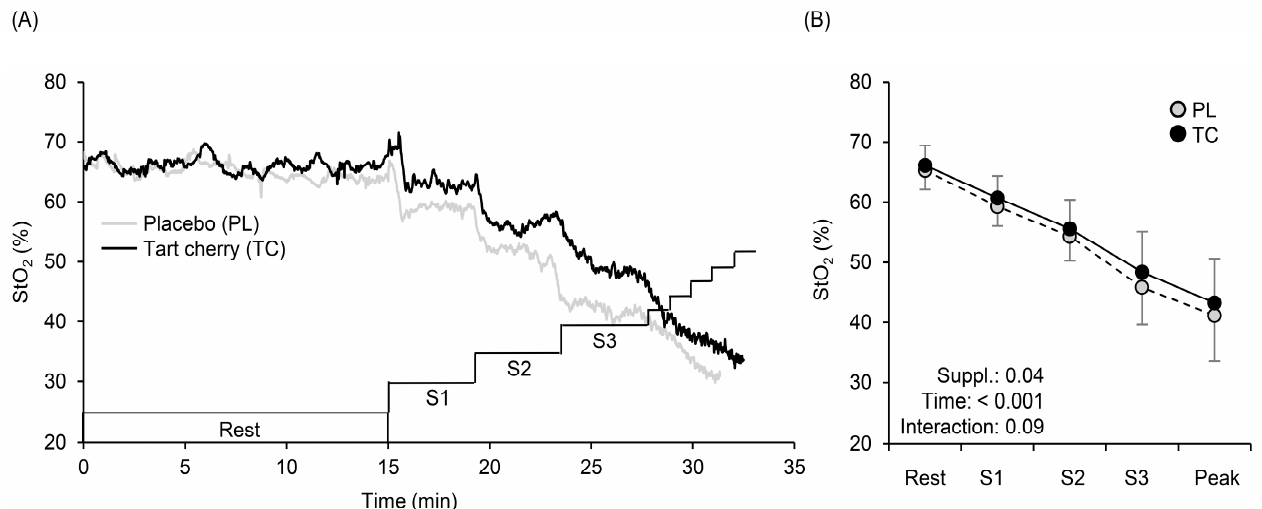
Figure 4. The typical time course changes of tissue oxygen saturation (StO 2 ) profiles at rest and during exercise ( A ). Changes in mean StO 2 with SD obtained at rest, at each stage (S1, S2, S3), and at exercise exhaustion (Peak) after 5 days of tart cherry (TC) and placebo (PL) supplementation ( B ).